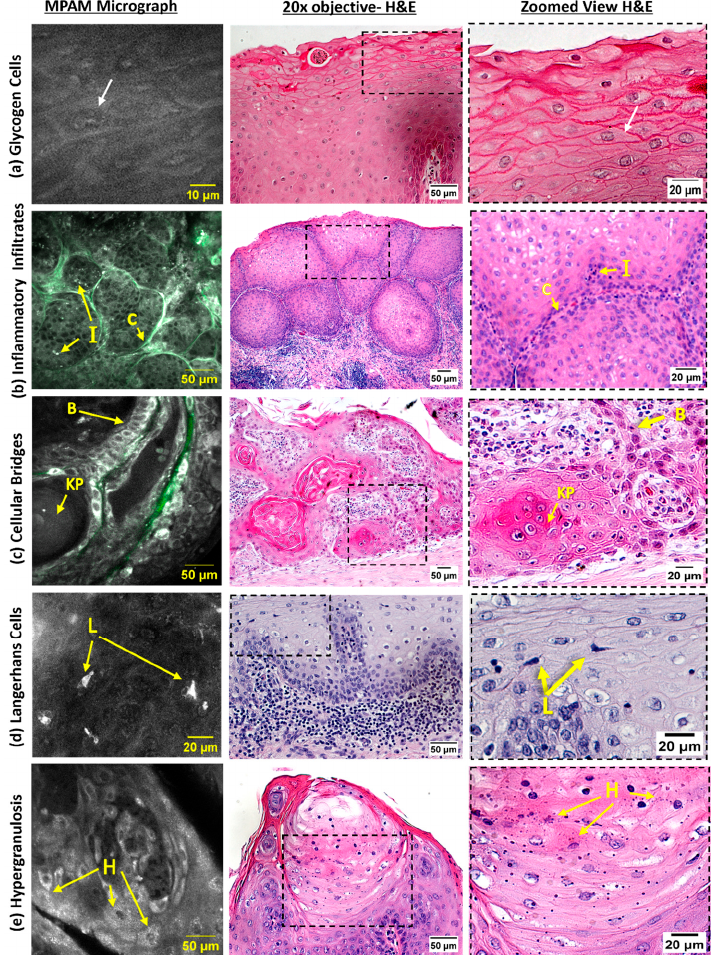
Figure 6. Additional features identified with MPAM in intact specimens from head and neck tumors. MPAM images from tumors (first column) with corresponding H&E following imaging. ( a ) Glycogenic cells (identified by white arrows) are seen in the first few layers of the epithelium. Immune infiltrates ( b ), noted as “I”, can be found interspersed in squamous islands, surrounded by collagen (shown in green and identified by “C”). Cellular bridges ( c ), noted as “B”, can be seen connecting to a keratin pearl (“KP”), with strands of collagen (colored green) nearby. Langerhans cells ( d ), emphasized by “L”, can be found in the epithelial mid-layers of a region of interest. Hypergranulosis ( e ), identified as “H”, can be observed near the surface of the tissue. Microscopy FOV 321 × 321 µ